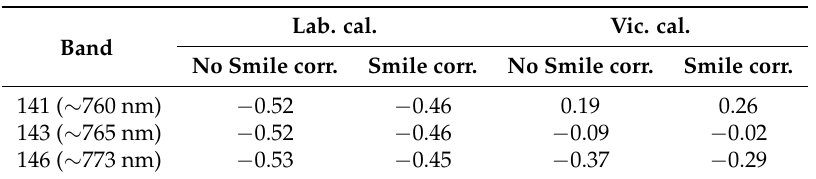
Table 7. Overview: Spectral in-orbit validation using the Oxygen A band absorption. Shifts in [nm] calculated as average over all cross-track elements relative to the nominal band wavelengths for the Gobabeb scene DT2019020405. “Lab. cal” refers to the pre-launch laboratory calibration, “Vic. cal.” to the vicarious in-orbit calibration. Lab. cal. Vic. cal. Band No Smile corr. Smile corr. No Smile corr. Smile